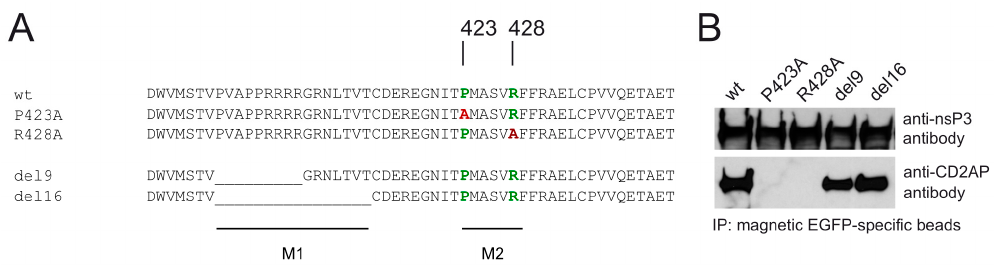
Figure 2. Mapping of CD2AP-binding site in HVD of CHIKV nsP3. ( A ) Sequences of two consecutive potential SH3 domain ligands (M1, M2) in HVD of CHIKV nsP3 (wt) and positions of the mutations that were introduced into EGFP CHIKVnsP3HVD expression constructs: Δ 9, Δ 16, P423A, R428A, Δ 16 + P423A, Δ 16 + R428A; “_” designates deleted residue; ( B ) Flp-In T-REx cells were transfected with plasmids expressing CHIKVnsP3HVD harbouring mutations indicated above the panel; 24 h later immunoprecipitation (IP) via EGFP-capturing beads was carried out, obtained samples were analysed by immunoblot for the presence of CD2AP and EGFP CHIKVnsP3HVD.